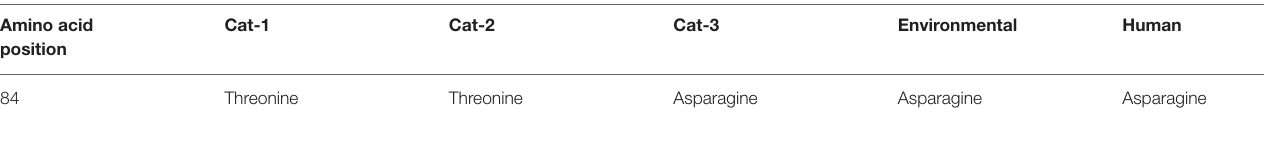
TABLE 4 | Amino acid change in Staphylococcus aureus mecA